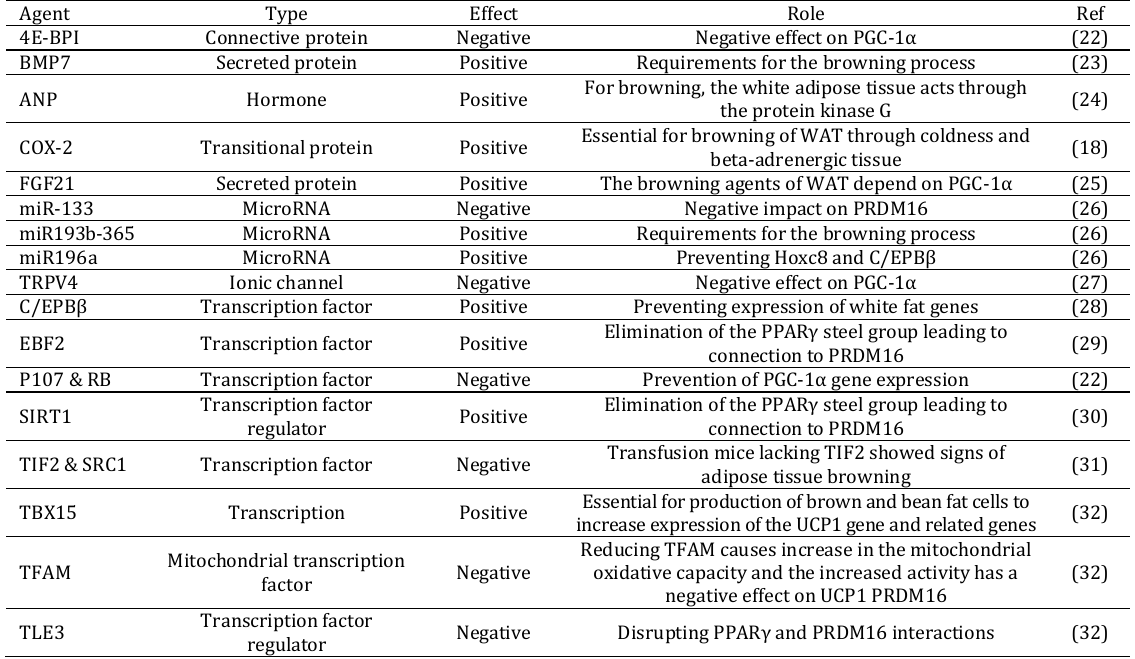
Table 1. factors affecting adipose tissue browning